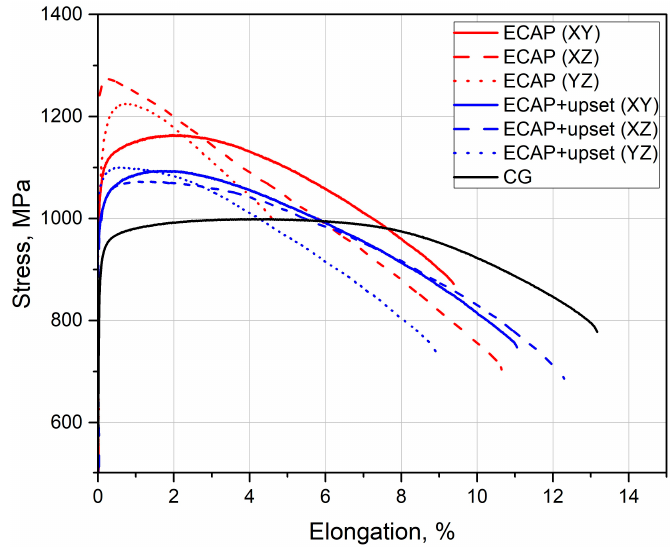
Figure 5. Typical curves from the tensile mechanical tests of the Ti-6Al-4V titanium alloy.